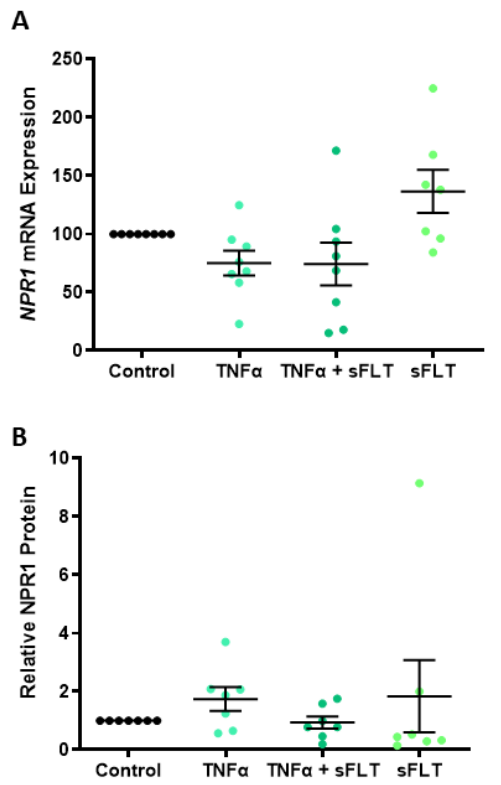
Figure 4. NPR1 expression and protein in cultured omental arteries are not affected by TNF α or sFlt-1. In cultured omental arteries, NRP1 mRNA expression ( A ) and protein levels ( B ) were unaltered by treatment with 10 ng/mL TNF α or 250 ng/mL recombinant human sFlt-1 alone or in combination. Data are mean ± SEM, n = 7–8. 2.3. ANP Increases Heme Oxygenase (HO) ‐ 1 Expression but Does Not A ff ect Human Umbilical Vein Endothelial Cell (HUVEC) Proliferation or Migration Known for its critical role in the prevention of vascular inflammation, HO ‐ 1 mRNA expression in isolated primary HUVEC is significantly increased with ANP treatments compared to the vehicle control (0 µM ANP, p < 0.001; Figure 5A). However, incrementally increasing doses of ANP did not affect HUVEC proliferation (Figure 5B) or migration (Figure 5C) compared to the vehicle control.